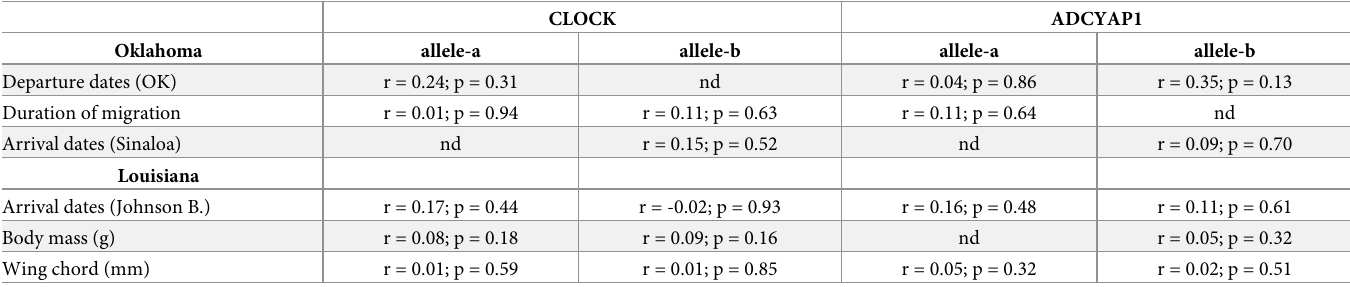
Table 3. Correlation analysis between allelic and phenotypic variation. Clock and Adcyap1 microsatellites did not correlate with any of the phenotypic variables investi- gated in Oklahoma and Louisiana buntings (p > 0.05). Allele-a indicates short alleles and allele-b indicates long alleles. Correlation values smaller than 0.01 are reported as nd (not detected). CLOCK ADCYAP1 Oklahoma allele-a allele-b allele-a